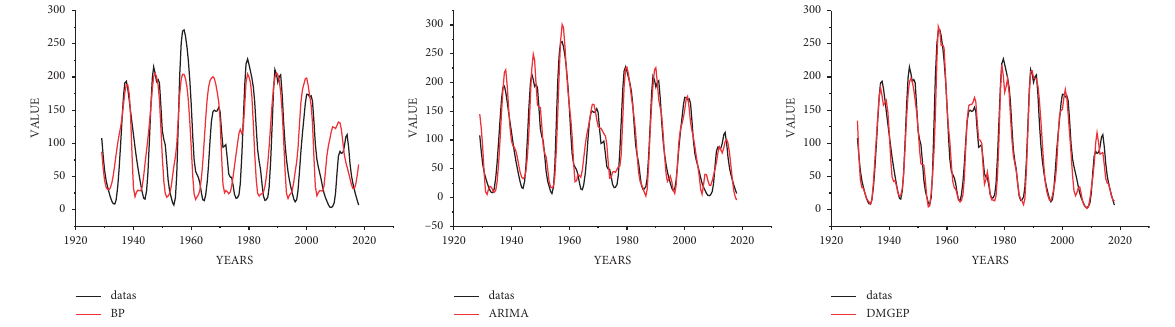
Figure 10: DM_GEP, ARIMA, and BP neural network simulation comparison experiment fitting effect. Table 5: Sunspot GEP-IPM-SPM comparative test data